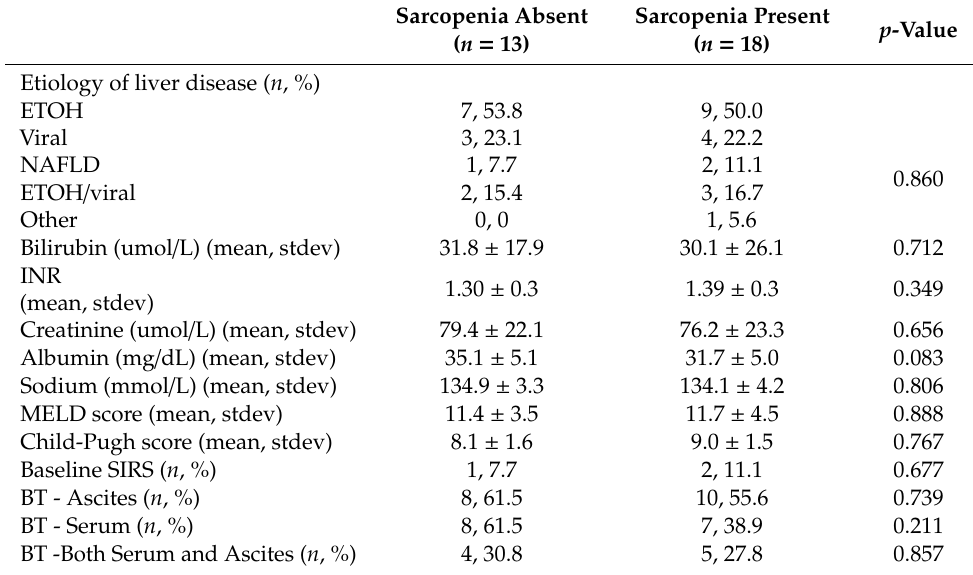
Table 2. Relationship Between Possible Risk Factors and